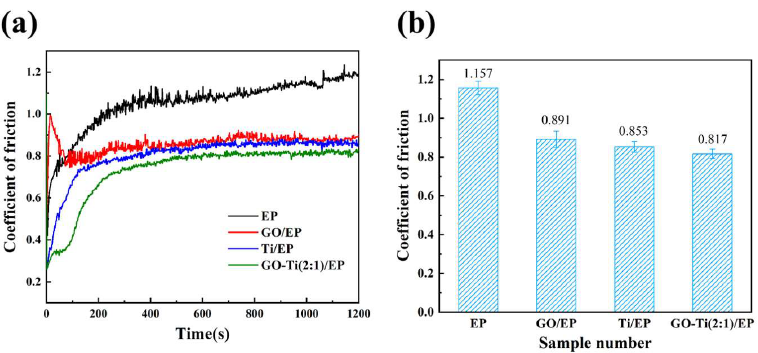
Figure 11. ( a ) Friction coefficient versus time and ( b ) average friction coefficient of EP, GO/EP, Ti/EP, and GO-Ti(2:1)/EP.